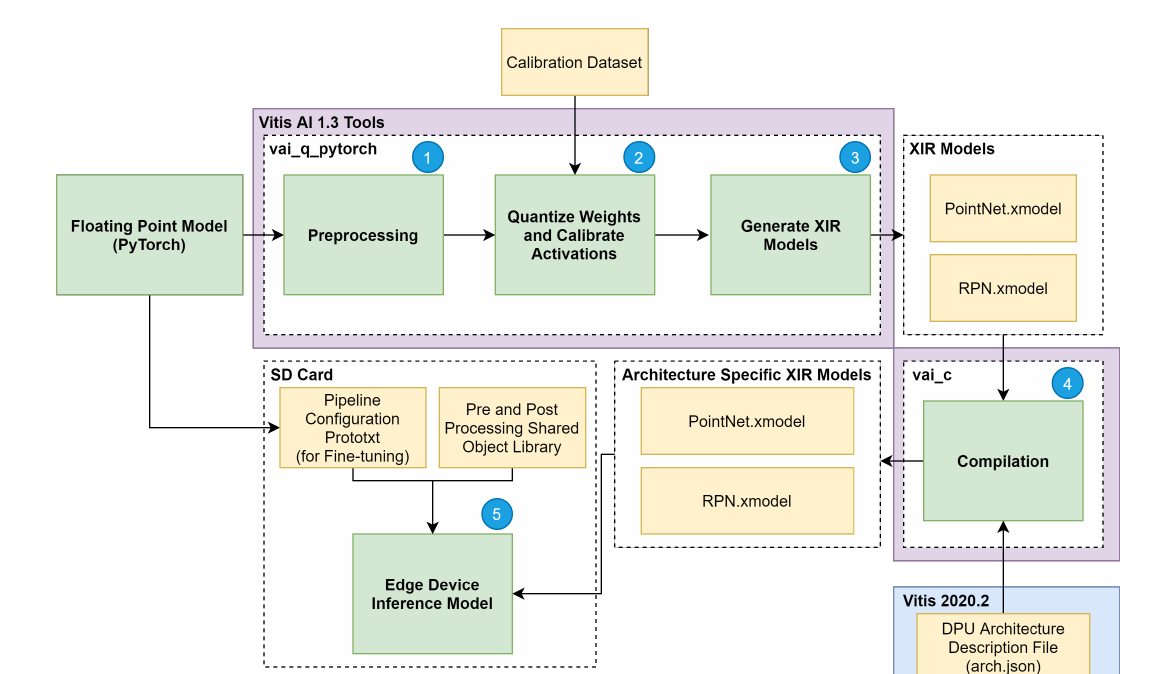
Figure 6. Model adaptation and optimisation based on post-training quantisation for on-board